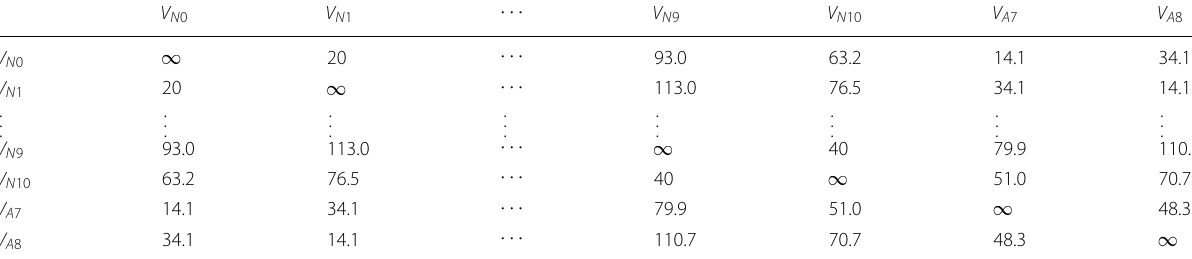
Table 4 Distance matrix after NFZ avoidance